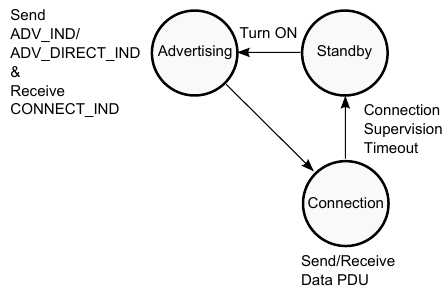
Figure 13. State diagram of the slave